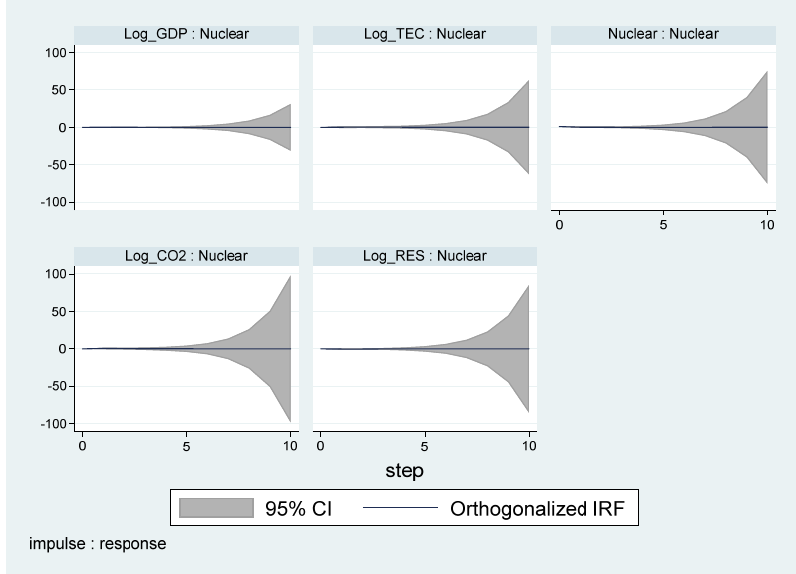
Figure 3. Orthogonalized impulse responses function.